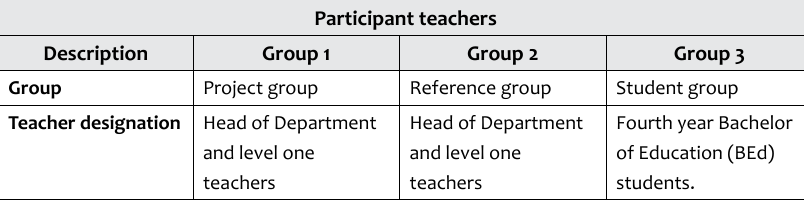
Table 1: Participating